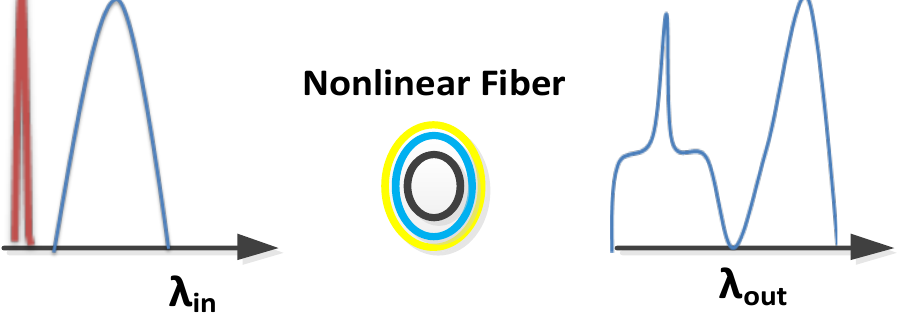
Figure 4. Cross phase modulation (XPM) effects inside nonlinear optical medium.